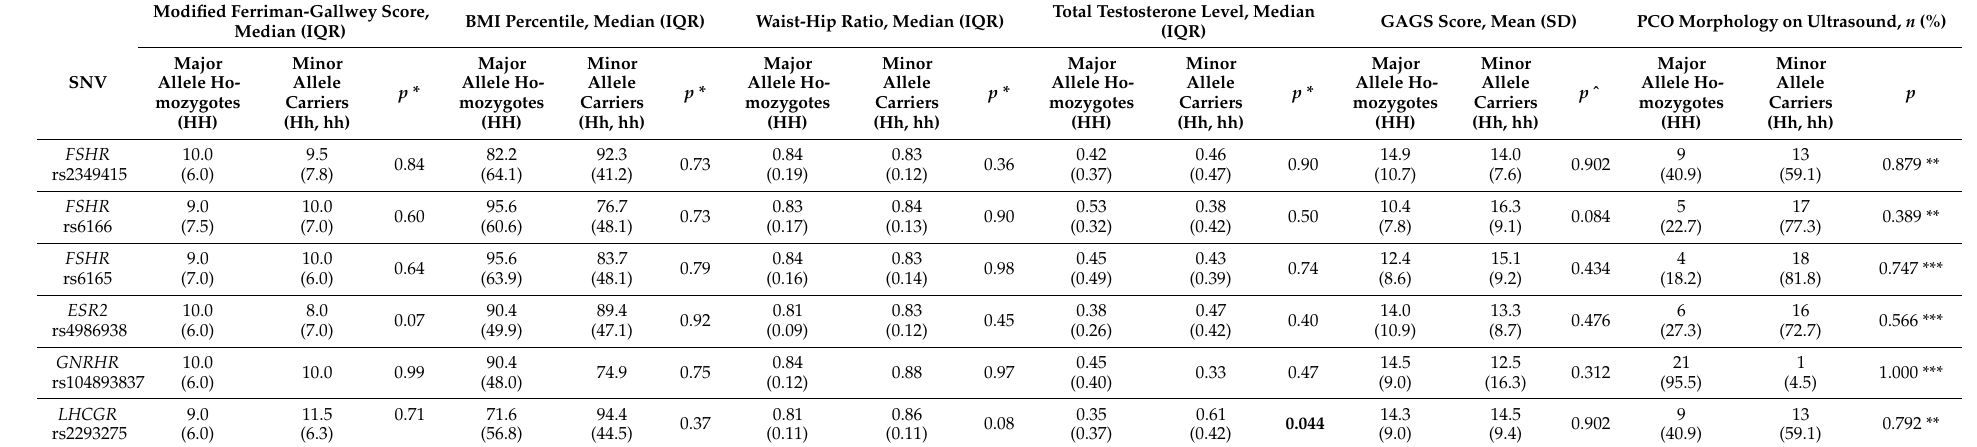
Table 4. Phenotype associations with homozygous major (HH) and minor (Hh/hh) allele carriers in the PCOS